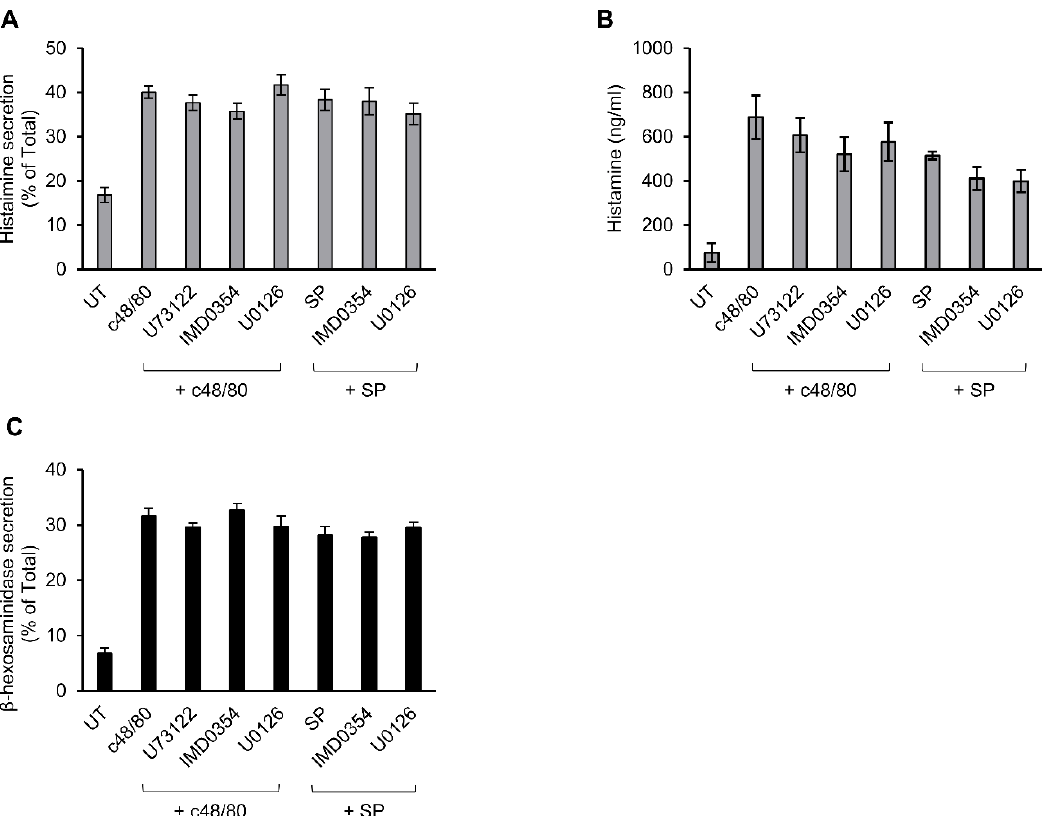
Figure 7. Inhibitor profiling of secretion in mouse peritoneal mast cells (MCs). Mouse peritoneal cells containing ~2 × 10 5 MCs/mL were incubated for 30 min, with vehicle or 10 µ M U73122, 10 µ M U0126 or 0.5 µ M IMD0354. Cells were then stimulated by either 10 µ g/mL c48/80 or 100 µ M SP, for a further 30 min. Secretion of histamine and β -hexosaminidase was determined. Histamine release is presented as percentage of total ( A ) and absolute amounts ( B ), which were determined by assaying histamine standards. β -hexosaminidase release is presented as percentage of total ( C ). Data are the means ± SEM (c48/80: n = 4; SP: n =